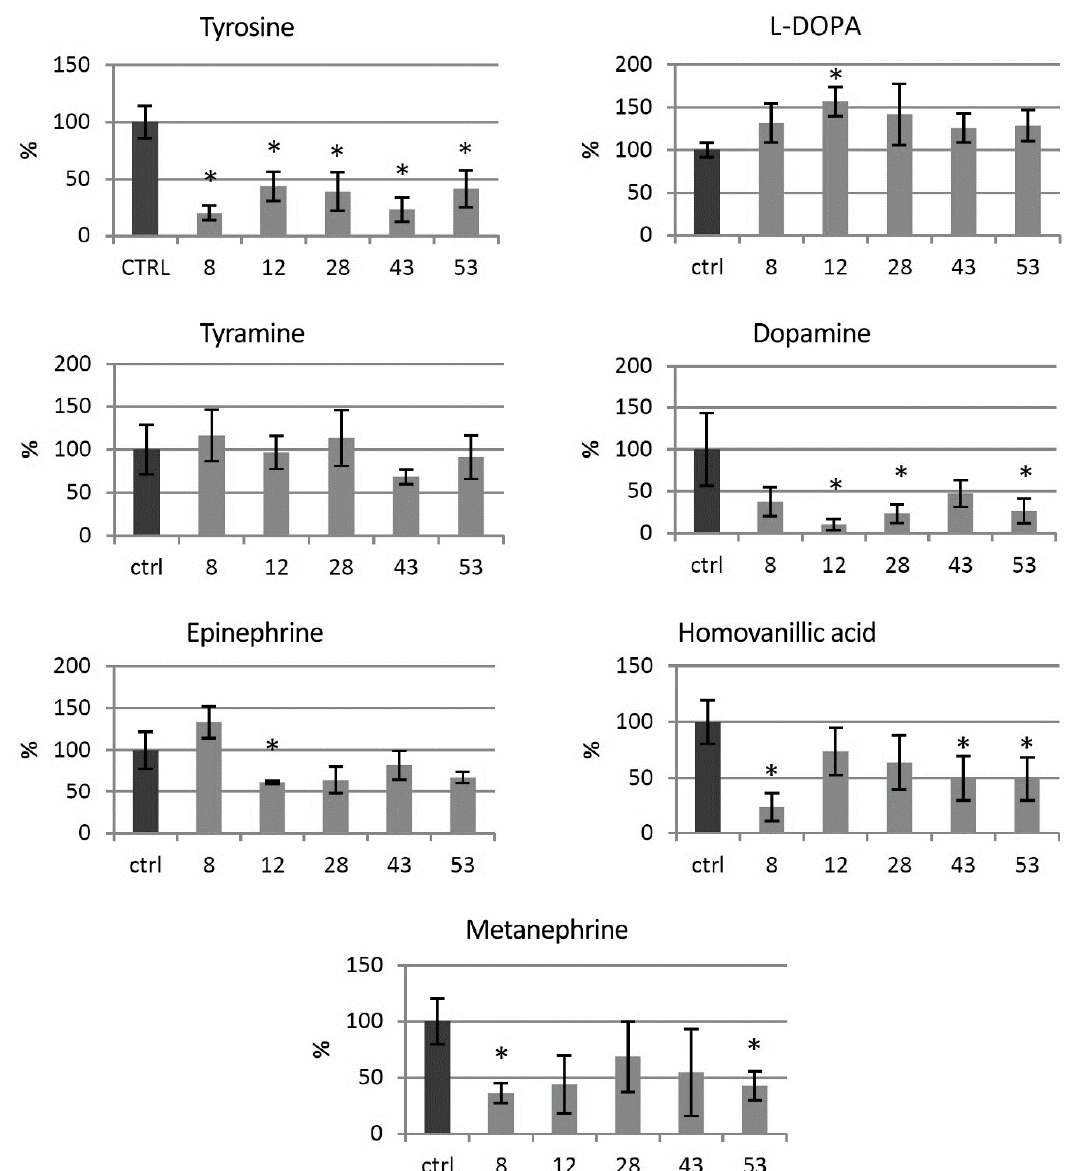
Figure 3. Levels of catecholamine group metabolites in HTZ transgenic lines relative to the control (non-transgenic potato) obtained with the GC–MS technique, presented as the means of six biological replicates ± standard deviation. Statistically significant changes ( p < 0.05) are marked with asterisks.